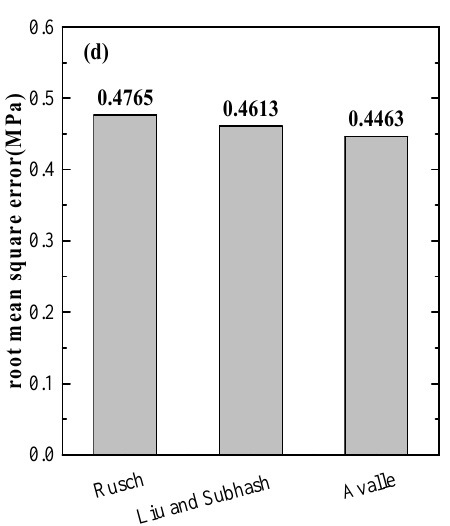
Figure 11. Comparison of the root mean square error of each model for ( a ) 0.263; ( b ) 0.298; ( c ) 0.326; and ( d ) 0.374 relative density values.